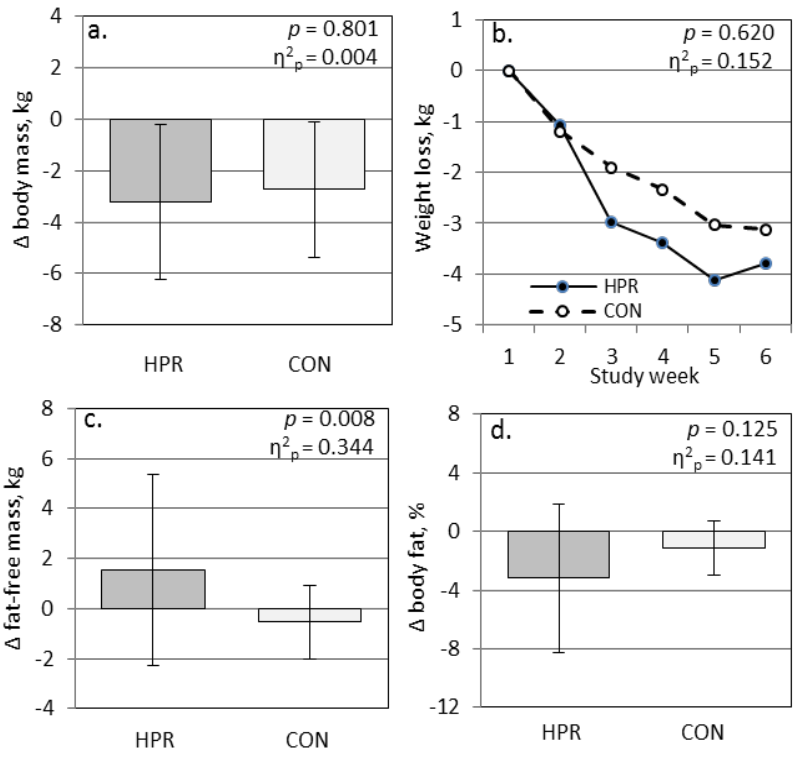
Figure 1. Change in ( a ) total body mass, ( b ) body mass by week, ( c ) fat-free mass, and ( d ) body fat percentage participants randomized to the energy-restricted diet composed of traditional breakfast cereal and gluten-free pasta dishes at lunch and dinner (CON; n = 11) or high-protein breakfast cereal and high-protein pasta dishes at lunch and dinner (HPR; n = 10). P represents general linear model test for change (∆) between groups controlling for gender; η 2p represents effect size (large, >0.140). PYY concentrations decreased among all participants during the trial ( − 45% overall, p = 0.007);